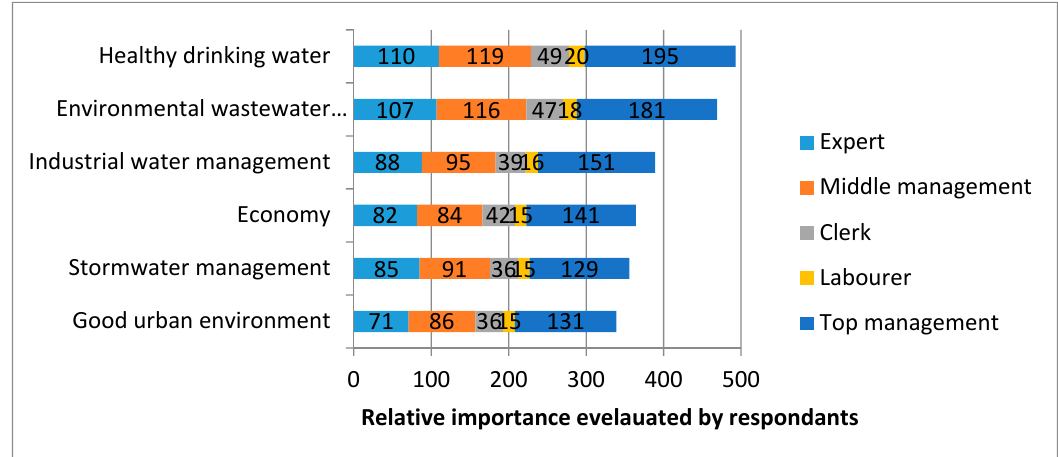
Figure2. Figure 2. Relative importance of water services according to respondents, illustrated by occupational groups.